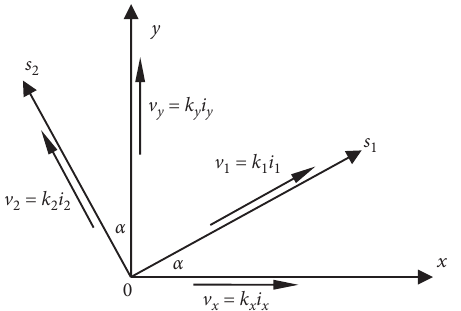
Figure 1: Permeability not coinciding with the axis in an aniso- tropic unsaturated